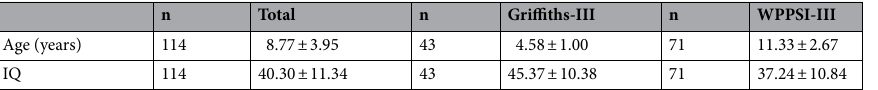
Table 5. Age and intelligence quotient (IQ) values expressed as mean ± standard deviation for the whole study population and for subjects tested with Griffiths-III and with WPSSI-III scales separately. n number of subjects referred to the group column on the right, IQ intelligence